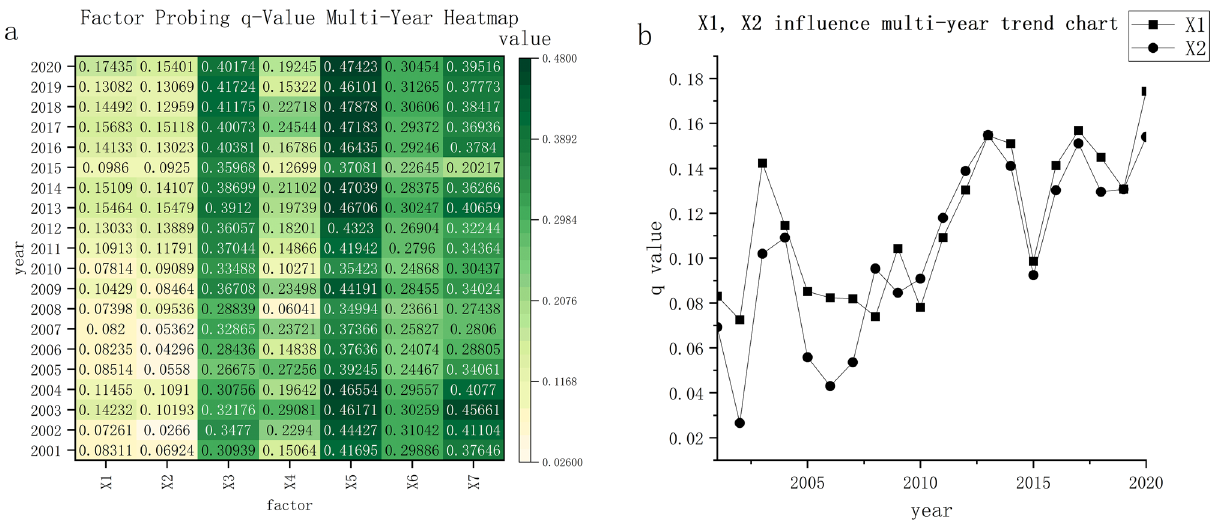
Figure 4. ( a ) Geodetector results heatmap (p-values all < 0.05), ( b ) trend chart of the influence of X1 and X2 over the